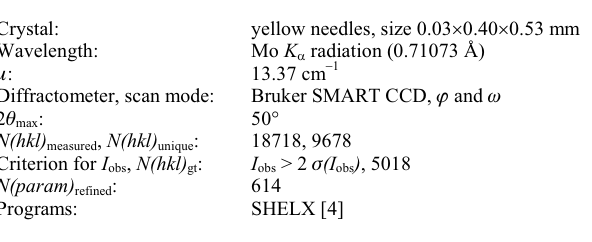
Table 1. Data collection and handling.